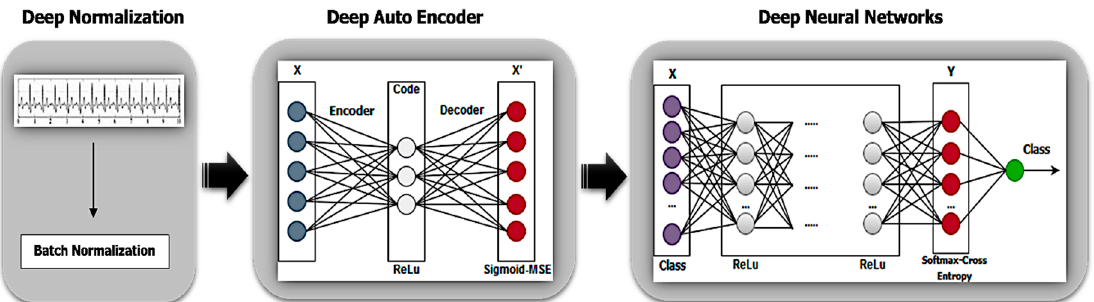
Figure 1. Deep learning architecture.